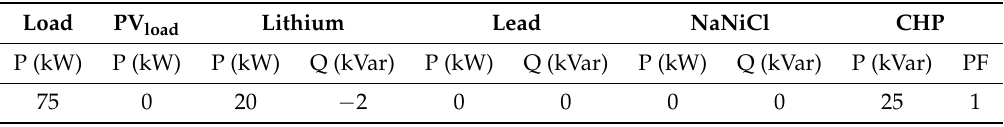
Table 2. Initial values set for Test